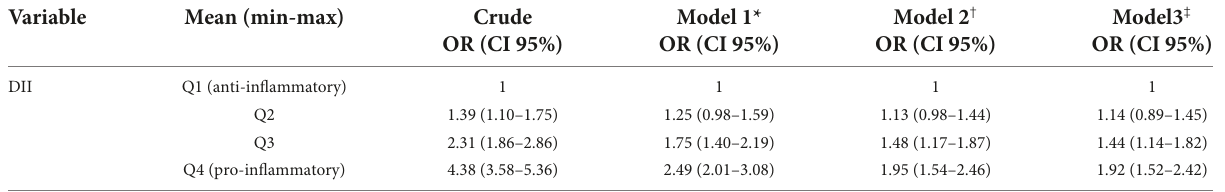
TABLE 2 Bivariate and the multivariate association between DII and CKD.